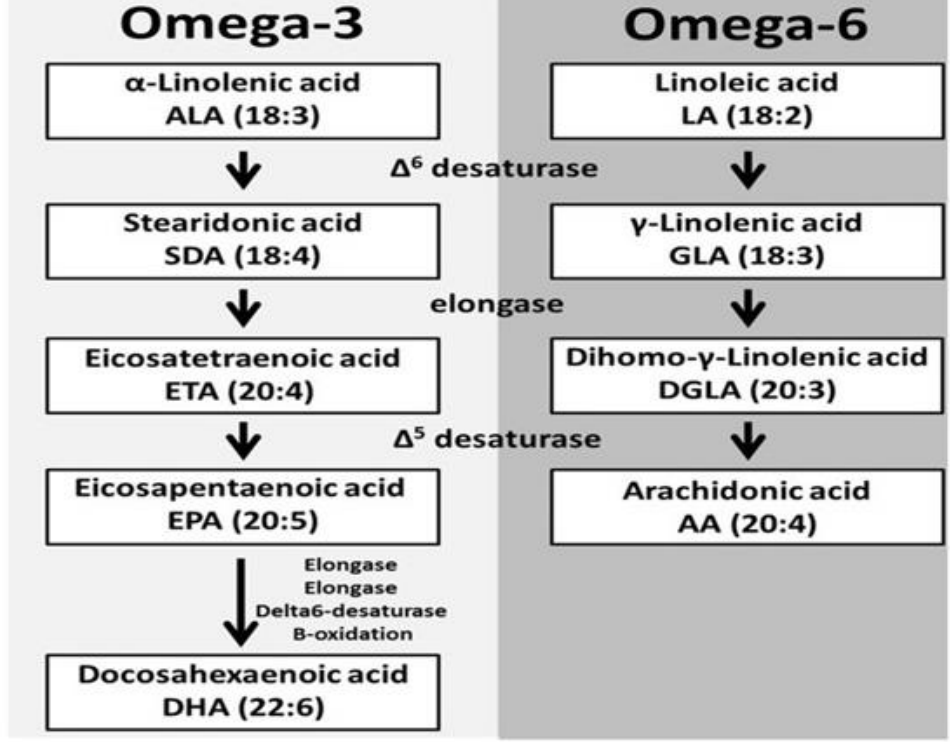
Figure 4. Polyunsaturated fatty acid biosynthesis.